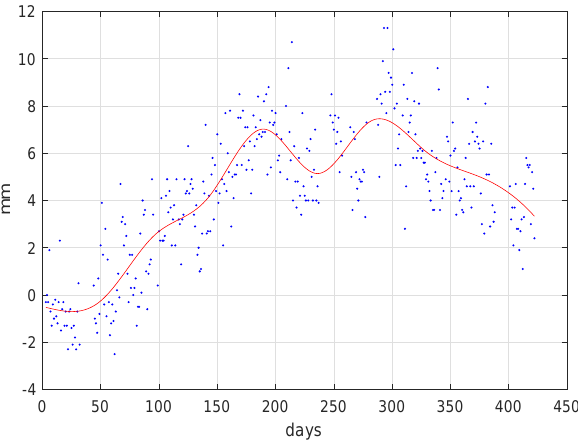
Figure 6. West point time series, East component. Observed values (blue dots) and model (red line)